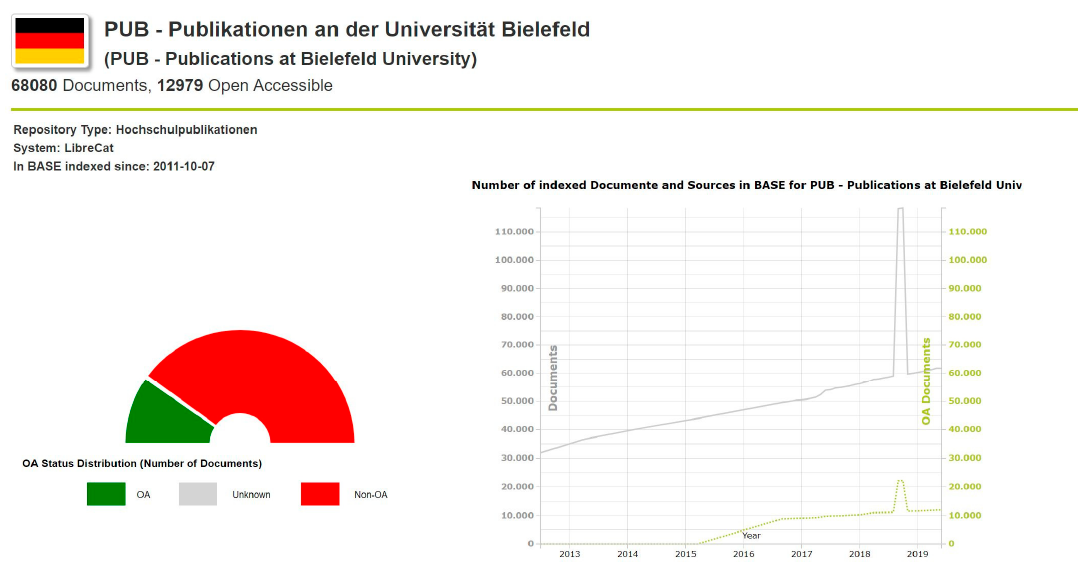
Figure 8. Repository profile for the Bielefeld University repository PUB.